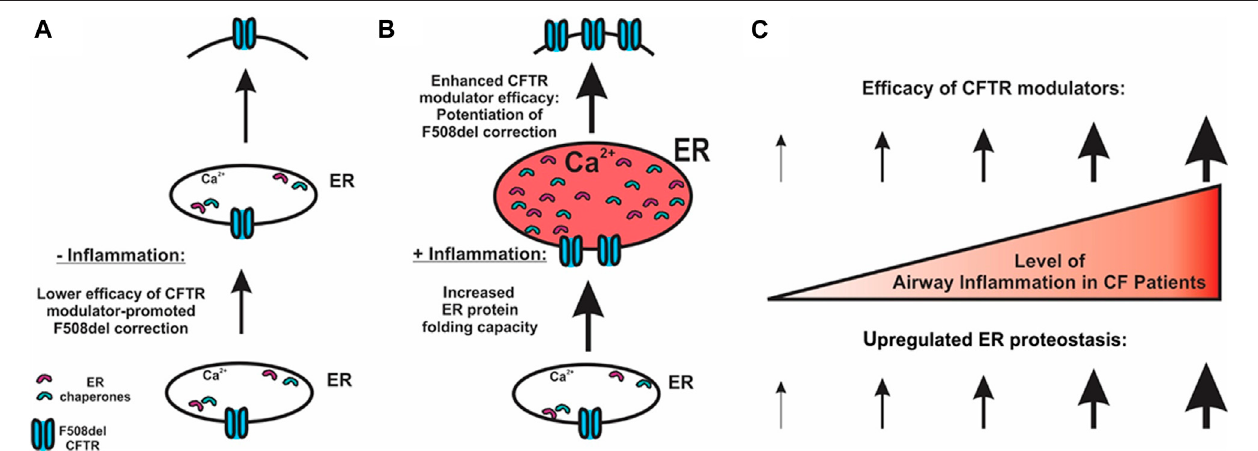
FIGURE 5 | Potential mechanism for airway in fl ammation-increased ef fi cacy of F508del CFTR modulators. (A) In the absence ofin fl ammation, lower expression of chaperones and lower ef fi cacy of CFTR correctors result in a lower level of CFTR folding at the ER. (B) CF airway epithelial in fl ammation increases the ER protein folding capacity, thereby enhancing CFTR modulator ef fi cacy. (C) Our model predicts that the higher the levels of airway in fl ammation, the higher the ef fi cacy of CFTR modulators regarding the rescue of